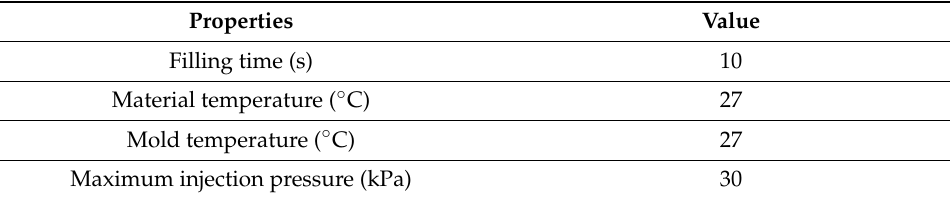
Figure 2. 3D CAD model and dimensions of ( a ) driving gear and ( b ) passive gear. Table 1. Main numerical modeling parameters used in the numerical